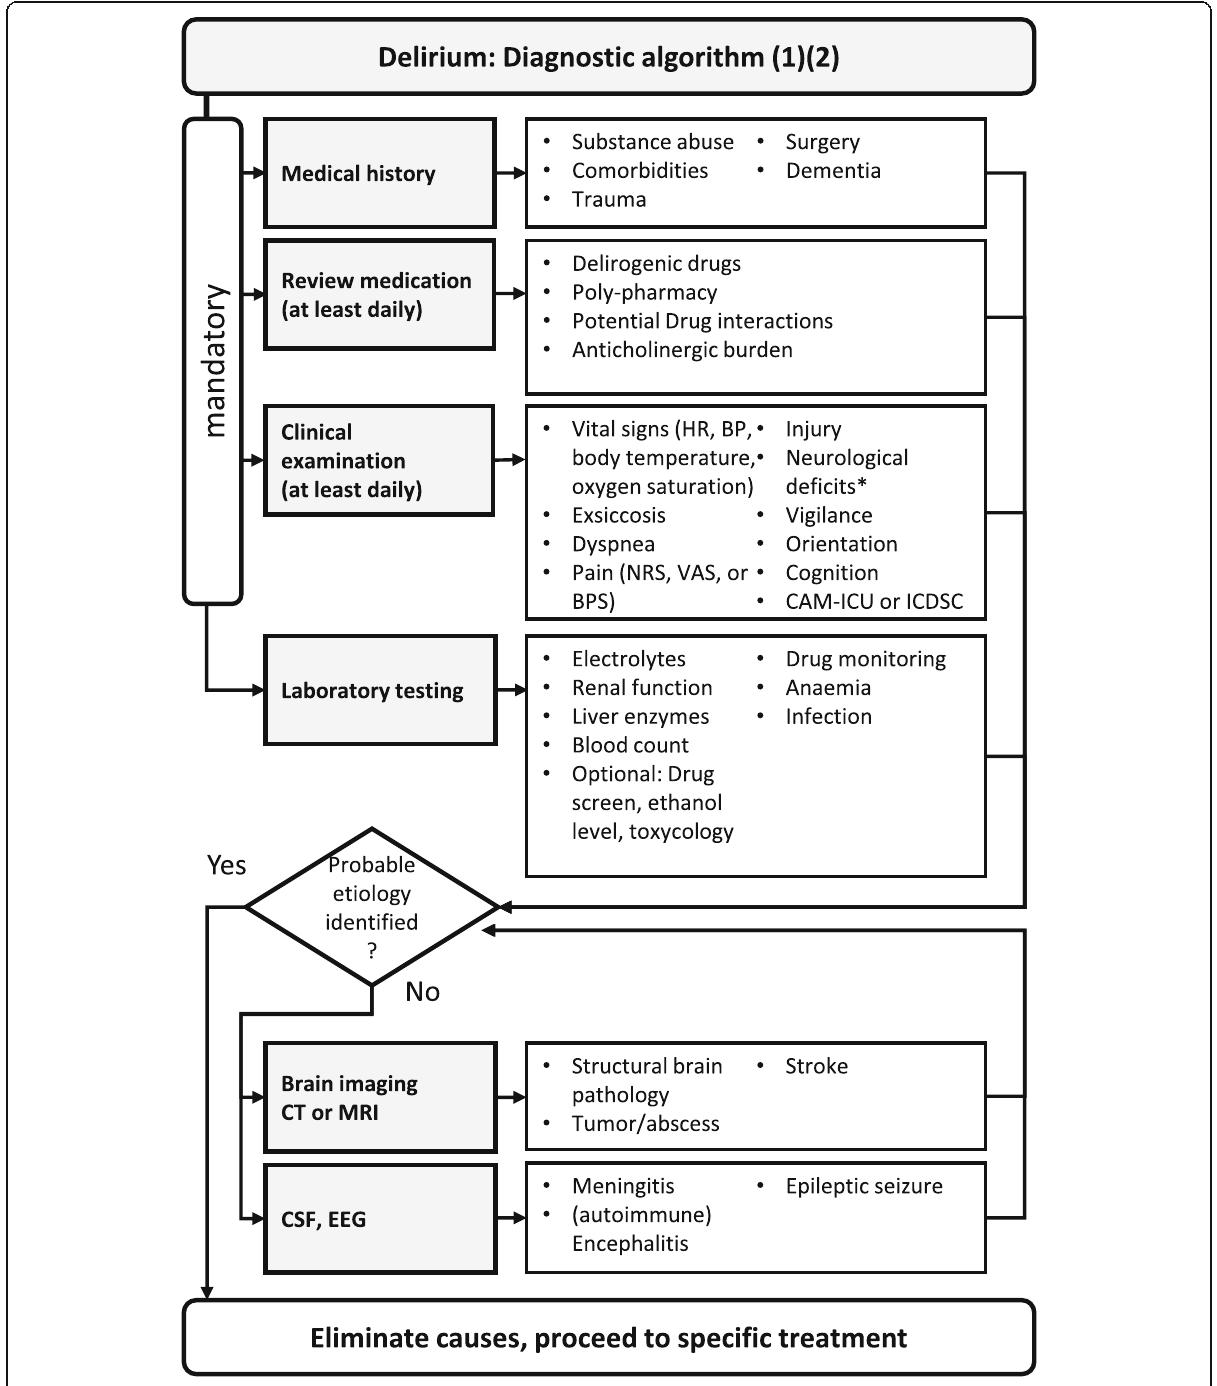
Fig. 1 Flow Chart for the diagnosis of delirium. BPS: behavioral pain scale, CAM-ICU: Confusion Assessment Method in the Intensive Care Unit, CT: computed tomography, CSF: cerebrospinal fluid, EEG: electroencephalography, FORTA: Fit for the Aged list, ICDSC: Intensive Care Delirium Screening Checklist, MRI: magnetic resonance imaging, NRS: numeric rating scale, VAS: visual analogue